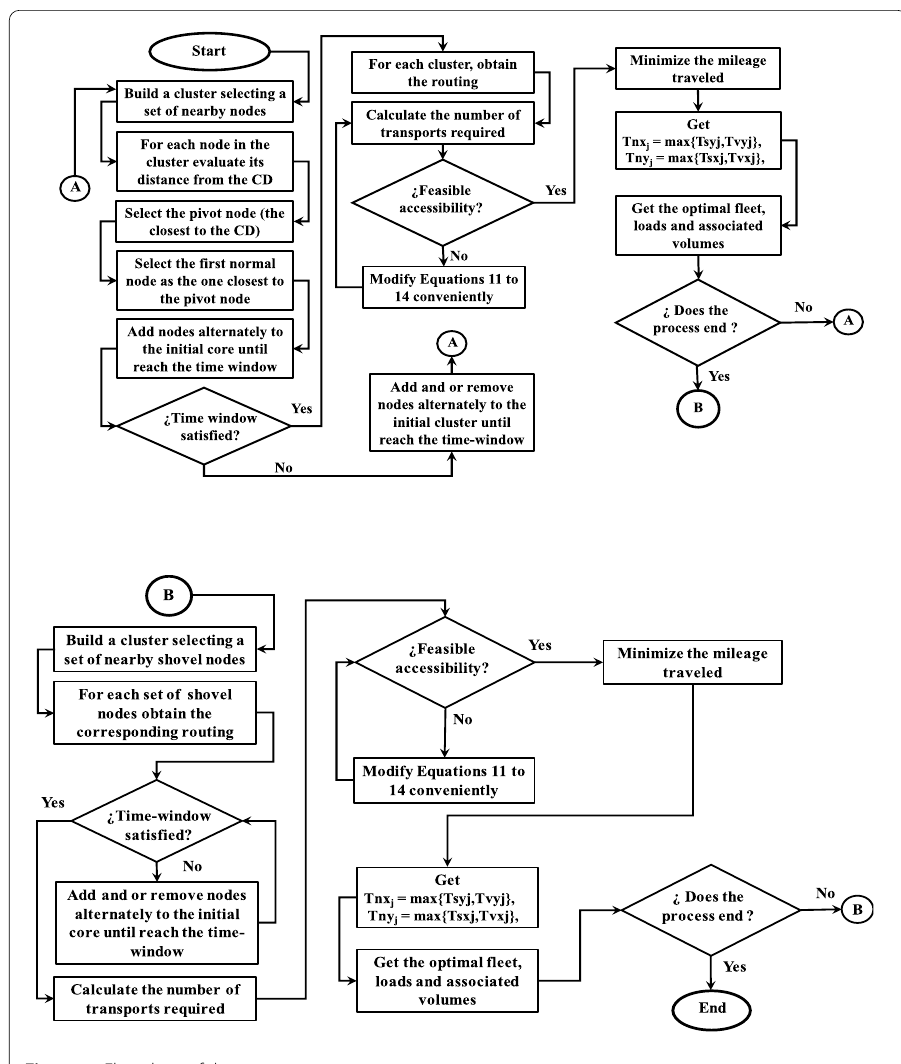
Figure 5 Flowchart of the